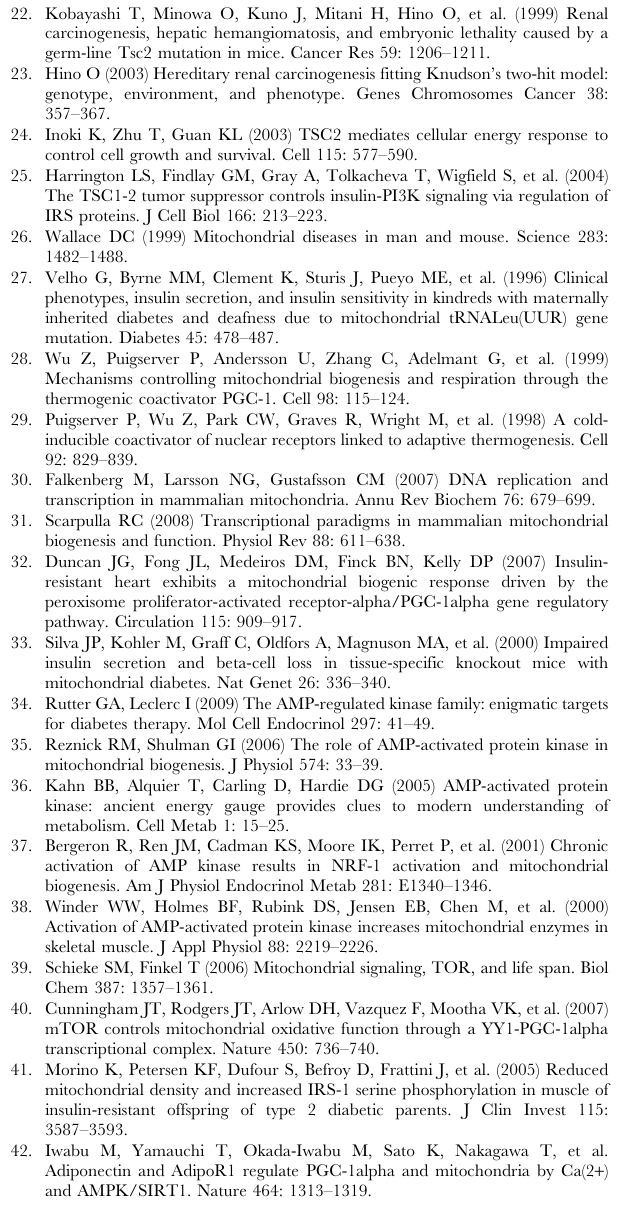
Table S1 Primers used for real-time RT-PCR